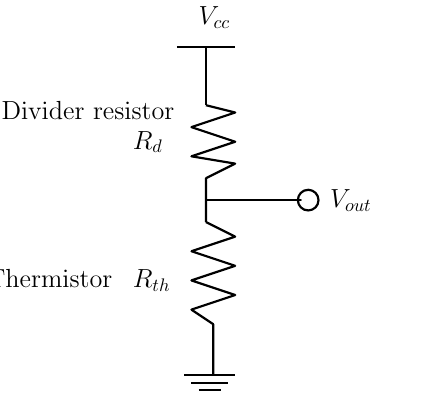
Figure 6. Voltage divider circuit to acquire the temperature data from the